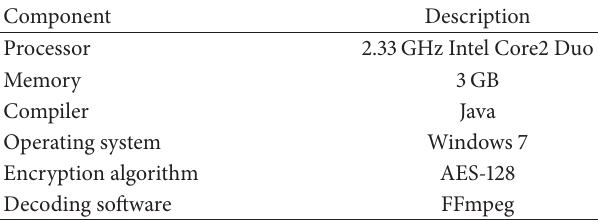
Table 5: Test environment specification.